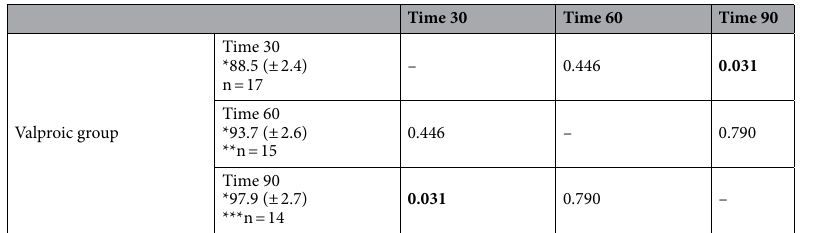
Table 2. Comparison of adherence (in p values) between time points in the valproic group (in days after randomization). *Mean percentage (standard deviation percentage). **2 unaccounted participants: one for not bringing the vial for accounting and another for having the treatment definitively interrupted 47 days after randomization due to tumor recurrence. ***3 unaccounted participants: one for having the treatment definitively interrupted at the previous time point due to tumor recurrence, another for having poor adherence in the third month of treatment and the third for having the treatment definitively interrupted 56 days after randomization due to a serious drug-related adverse event. Tabulated results represent p values calculated by the Bonferroni test. p-values < 0.05 are presented in bold.